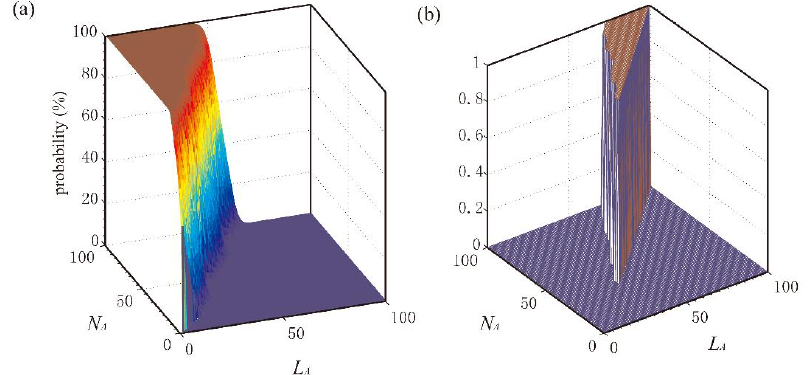
Figure 8. Parameter optimum for ascending window. ( a ) Using traversing search method to optimize L A and N A for ascending window, ( b ) Search the optimal L A and N A when testing probability is zero.